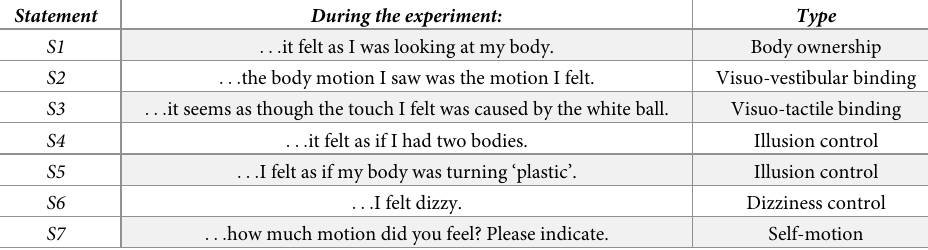
Table 2. Illusory ownership questionnaire. Statements S1–S6 were measured using a 7–point Likert scale, while S7 was measured using a 10–point visual analog